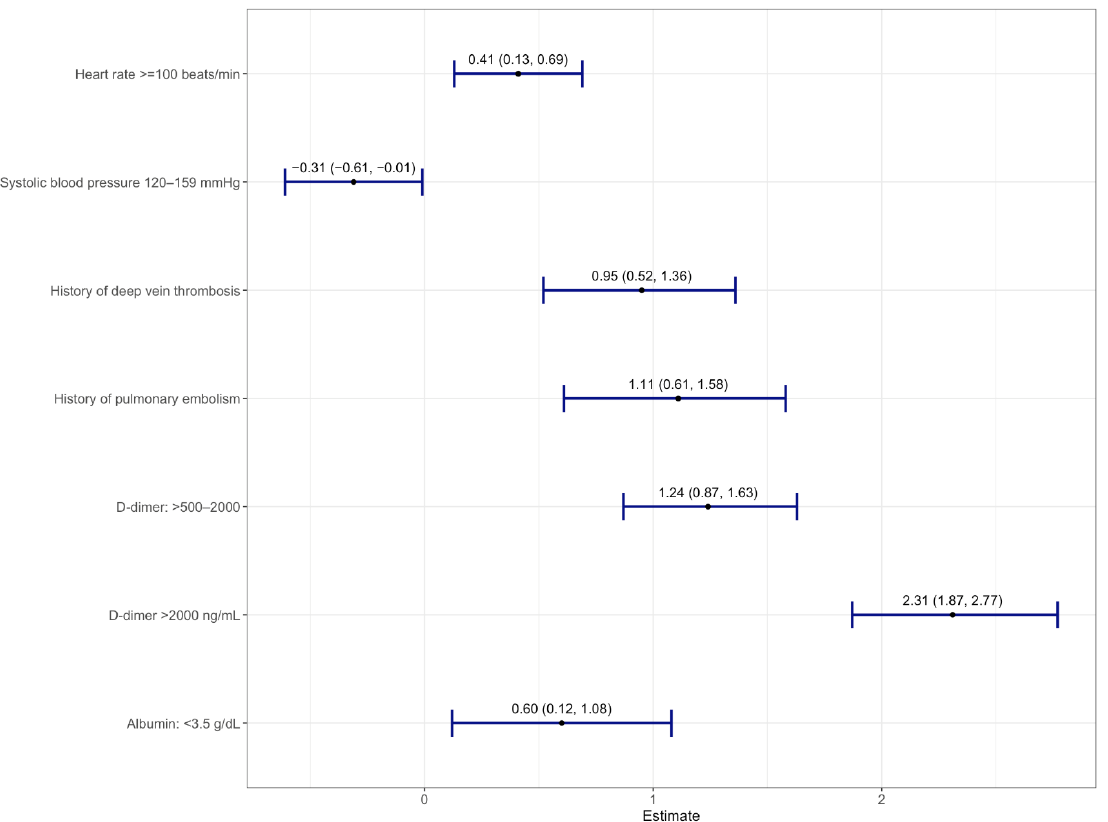
Table 2. The 3D-PAST risk assessment model with assigned scores.